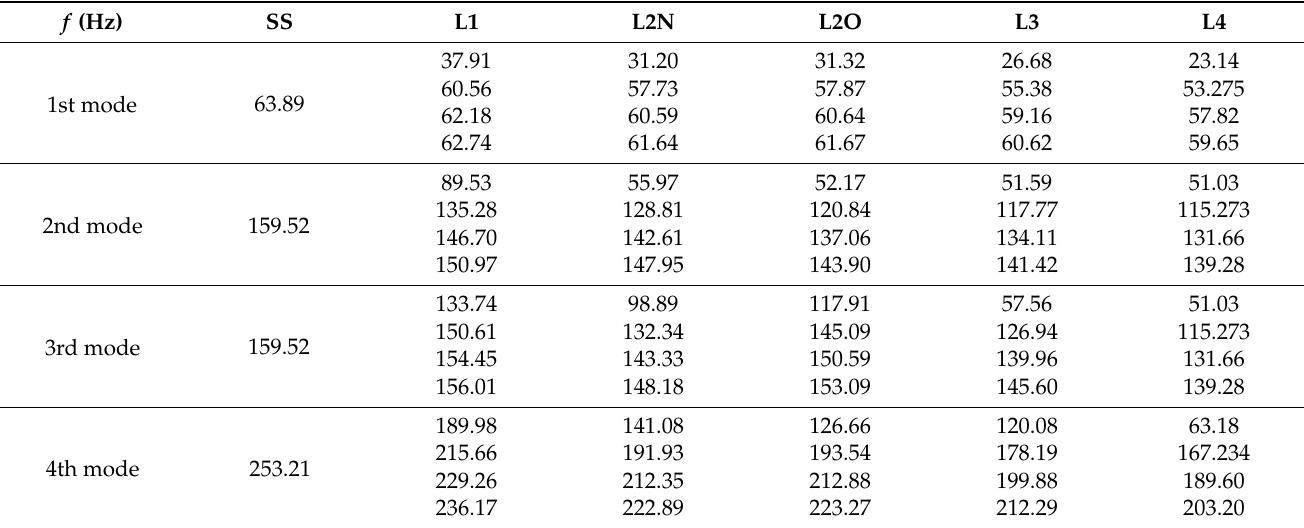
Table 2. Natural frequencies of the square panel with elastically supported